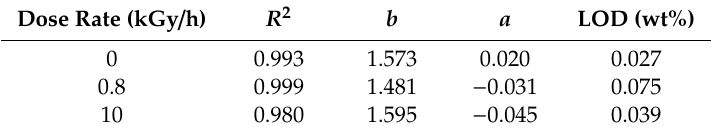
Figure 5. Calibration curves derived from the intensity ratio of Gd 501.5 nm/Ce 474.5 nm lines. The R 2 values and fitting parameters are listed in Table 2. Table 2. R 2 values and fitting parameters for Gd calibration curves. b : slopes of the curves, a : intercepts.